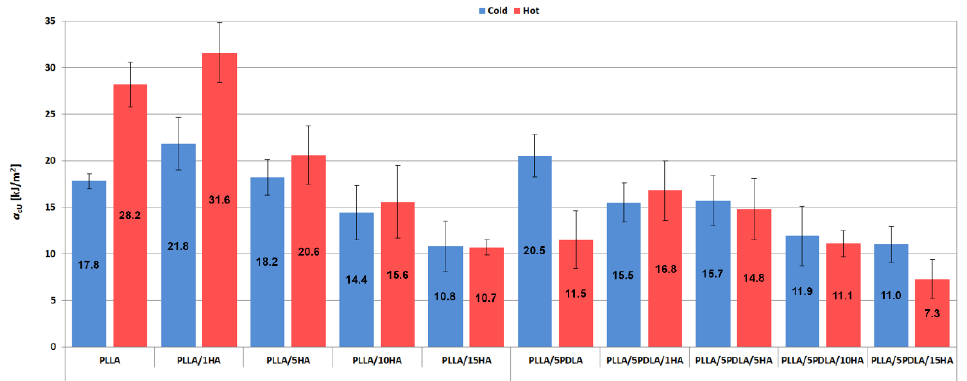
Figure 6. Impact toughness plots of samples from cold and hot